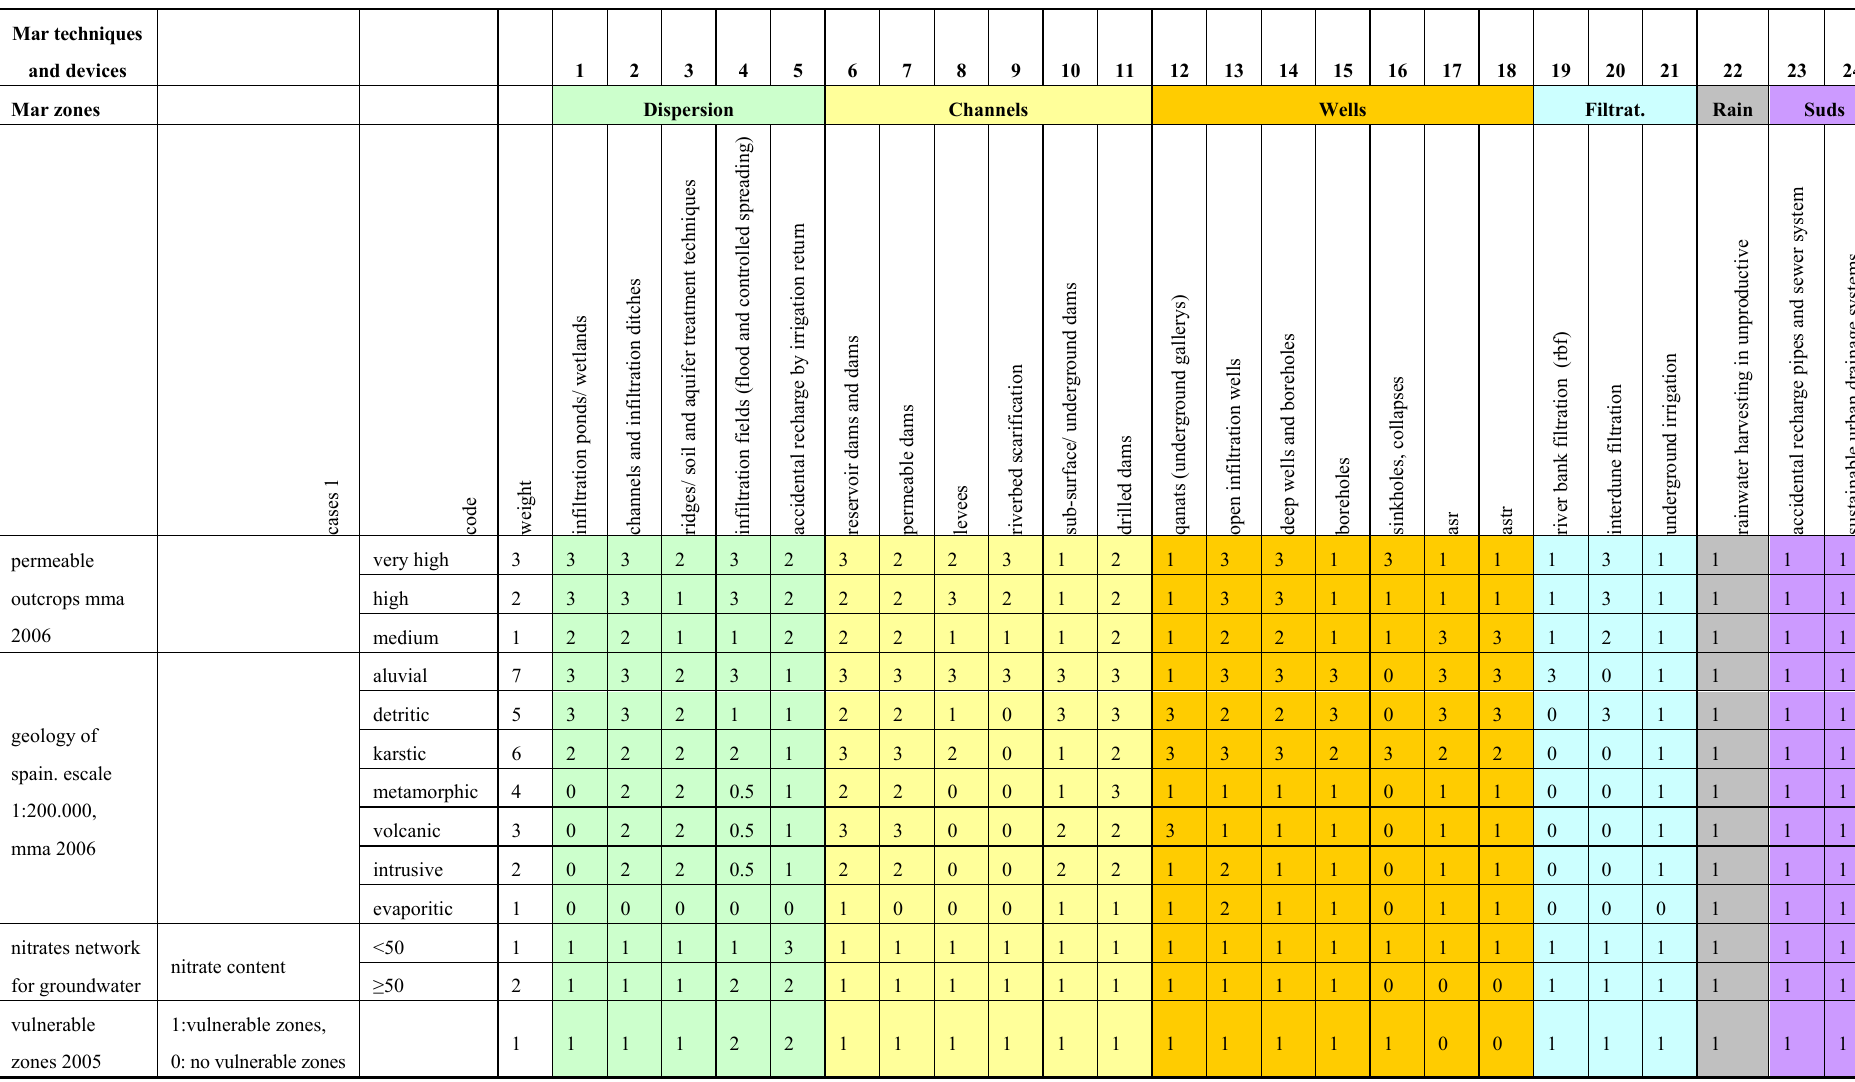
Table 3. Relating physical factors and indicators (based on GIS support) for different MAR